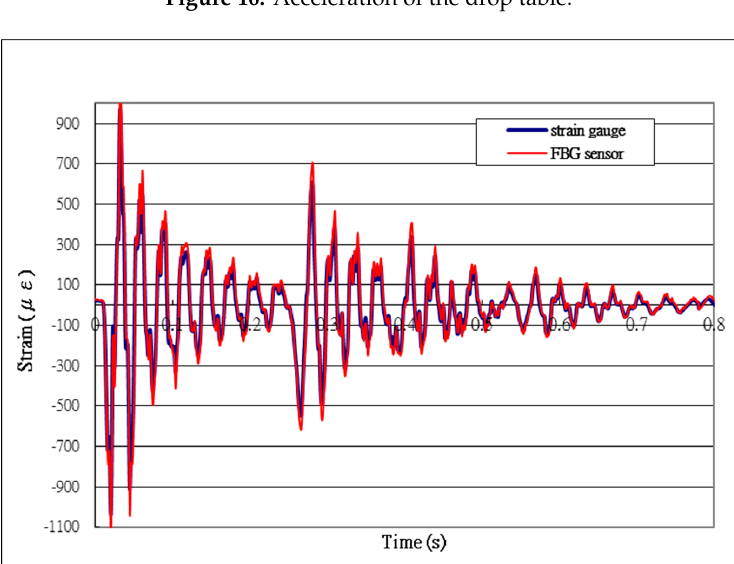
Figure 16. Acceleration of the drop table. Appl. Sci. 2019 , 9 , x FOR PEER REVIEW